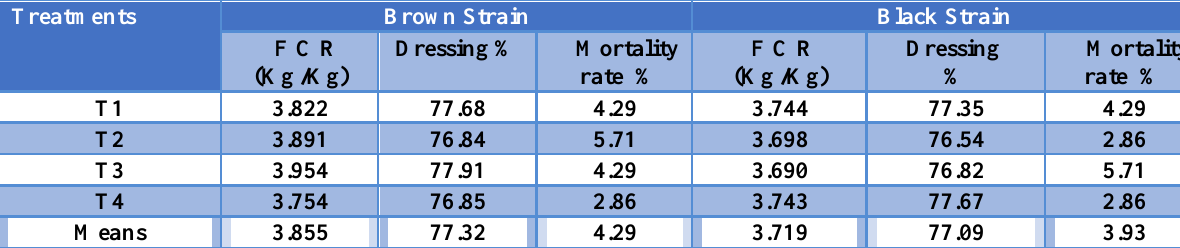
Table, 3: Effect of treatments in Feed Conversion ratio (Kg feed /Kg gain) Dressing percentage and Mortality